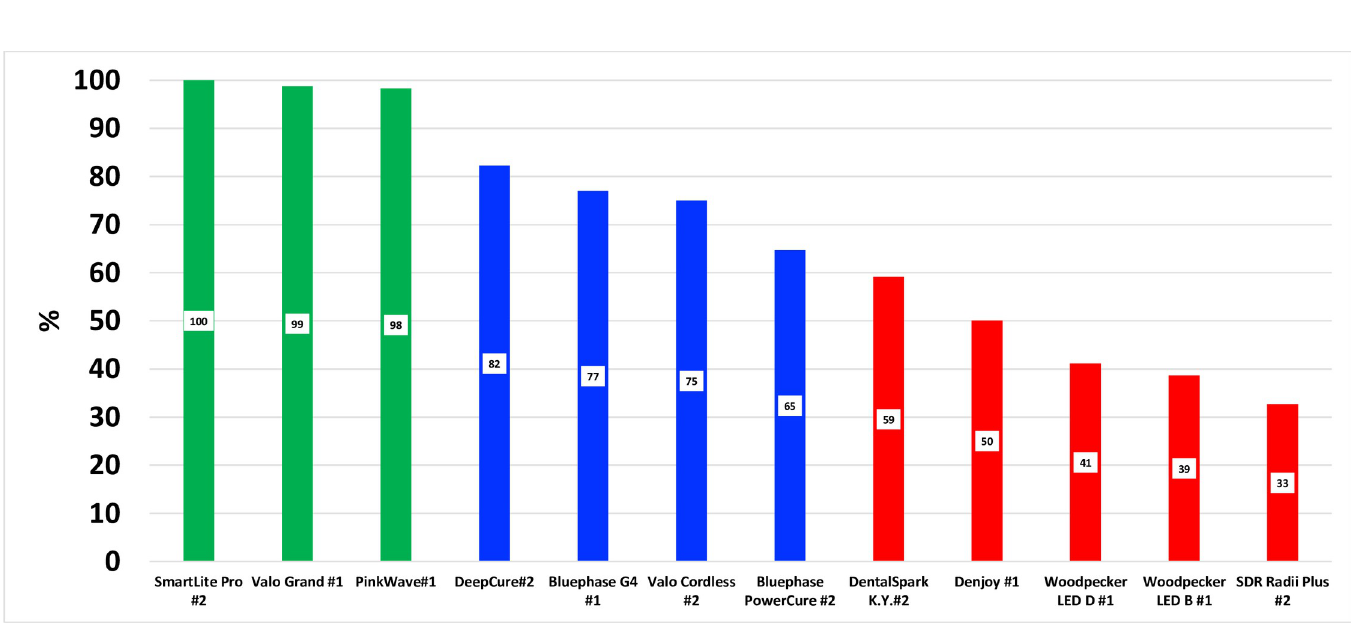
Fig 6. Comparison of the power output of the 12 LCUs described as a percentage of the most powerful LCU (SmartLite Pro) recorded using the ‘gold standard’ system.